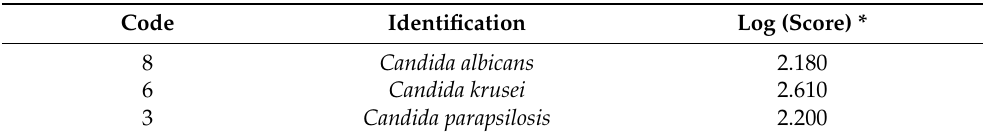
Table 1. Identification of Candida yeast by MALDI-TOF MS. Log (Score) values are reported as decision criteria for yeast identification. Code